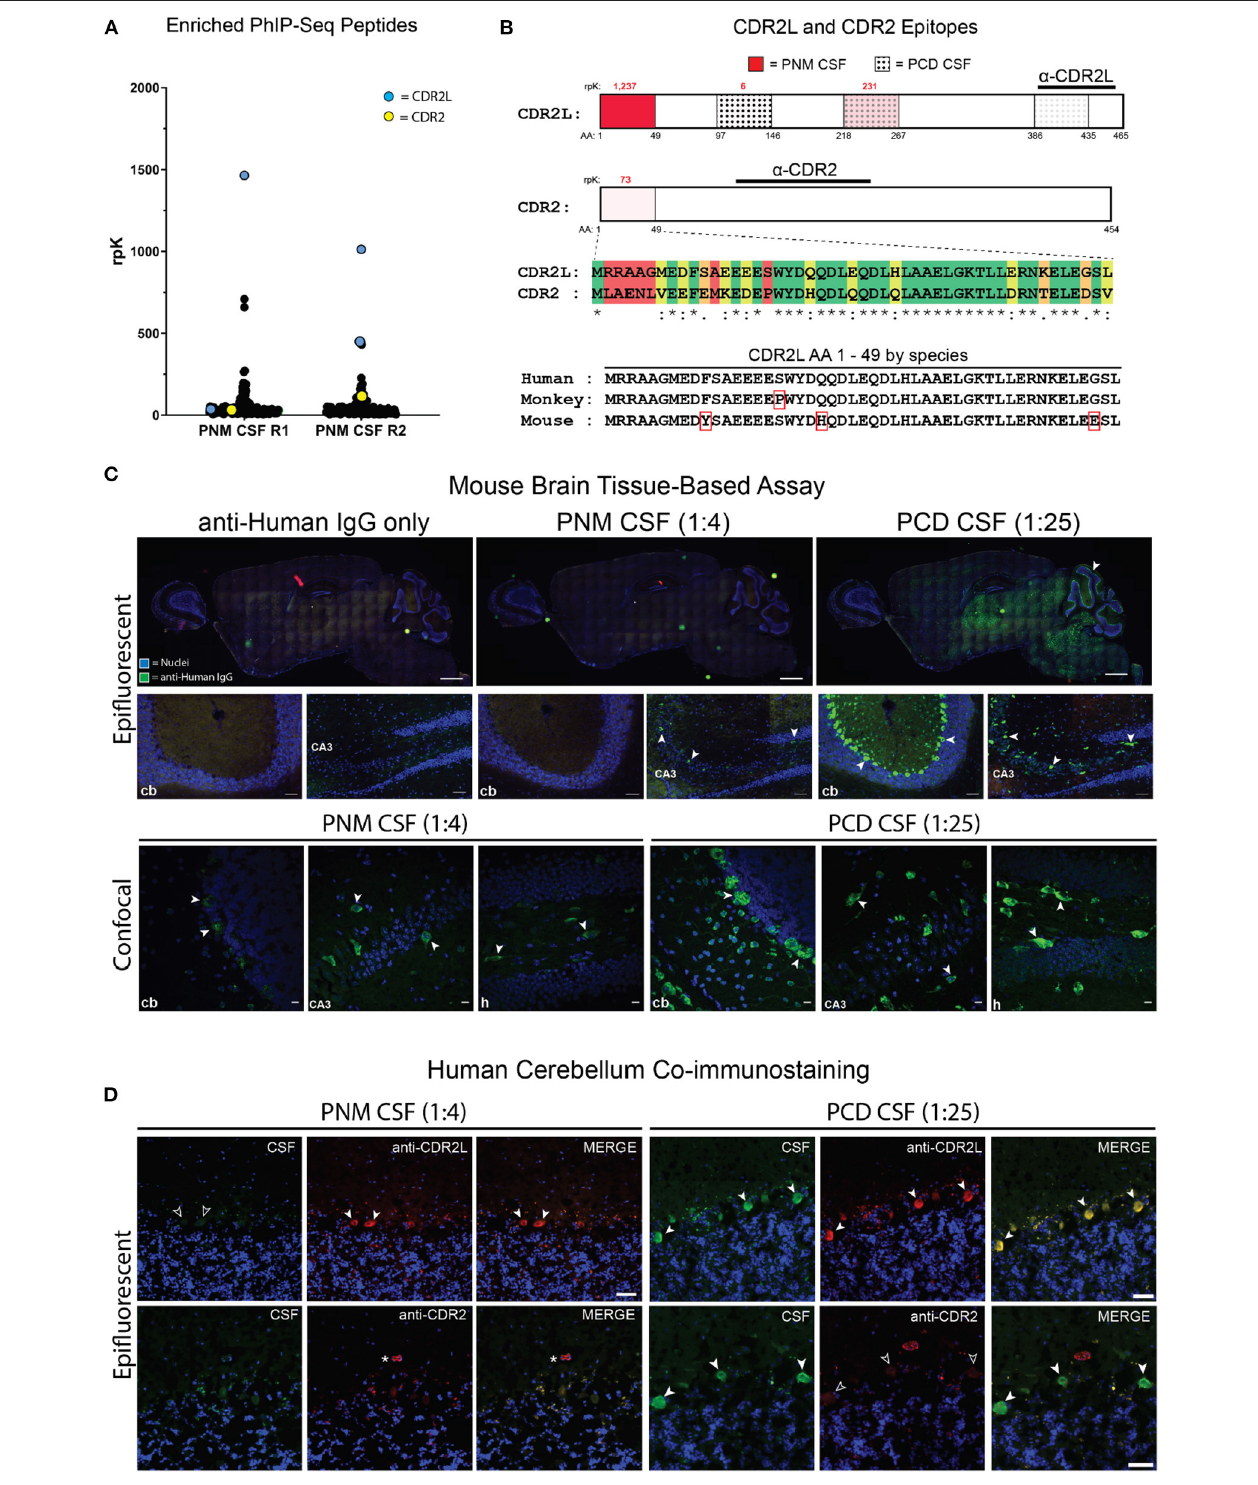
FIGURE 2 | Identification of anti-CDR2L and anti-CDR2 antibodies and PNM CSF tissue-based assay. (A) Dot plot of individual PhIP-seq-identified peptides that were enriched in both technical replicates at least 10-fold above reference samples (R1 and R2, replicates 1 and 2, respectively). The most enriched peptide in each replicate mapped to CDR2L (blue points). A CDR2 peptide (yellow) was also identified. PhIP-Seq data for all other enriched peptides (black) are available in Supplementary Table 2 . (B) CDR2L and CDR2 proteins and relevant epitopes. The intensity of red shading is proportional to the enrichment of that peptide by